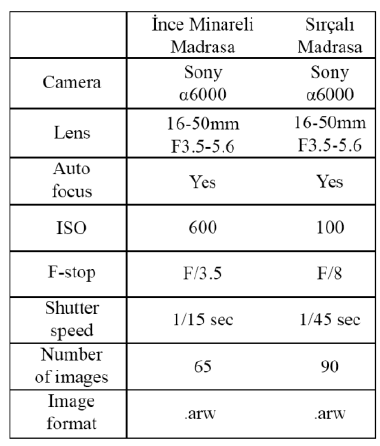
Table 1. Photogrammetry data gathering information.